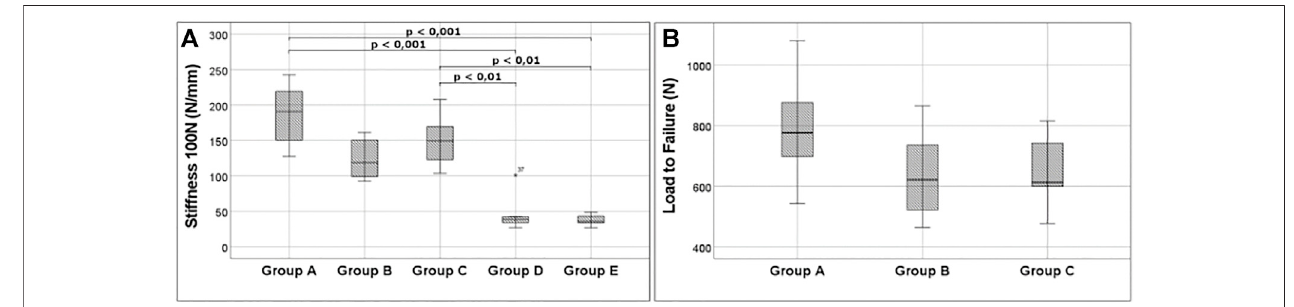
FIGURE 5 | Important outcome. (A) Stiffness at 100 N for all groups analyzed. A very low stiffness is noticeable for groups D and E, underlining the weakness of plating. (B) Boxplots show the high fi xation strength of 6.5-mm partial threaded cannulated screw screws. 5.0 headless cannulated compression screw, and 4.0-mm partial threaded cannulated screw can also resist high tension forces.